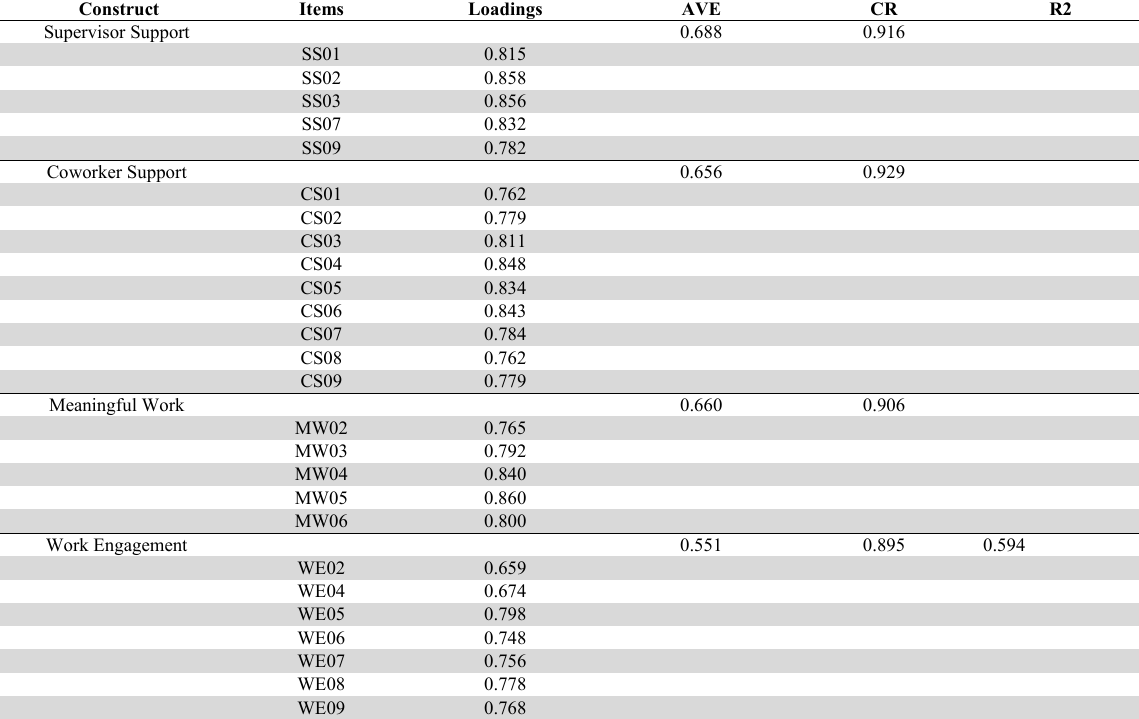
Fig. 1. Measurement Model Loadings, AVE and Composite Reliability